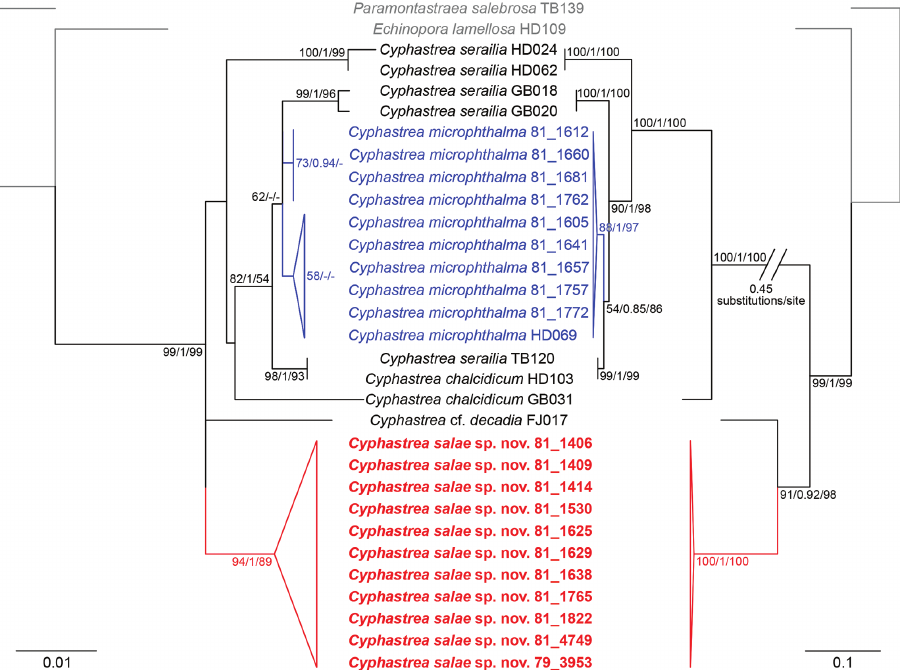
Figure 4. Maximum likelihood phylogenies based on the nuclear 28S rDNA (left) and mitochondrial noncoding intergenic region (right). Taxa in grey are outgroups. Cyphastrea salae sp. n. and C. microph- thalma in red and blue respectively. Numbers adjacent to each branch represent support values (maximum likelihood bootstrap ≥ 50; Bayesian posterior probability ≥ 0.85; maximum parsimony bootstrap ≥ 50). Cyphastrea salae and C. microphthalma originated from two distinct lineages.